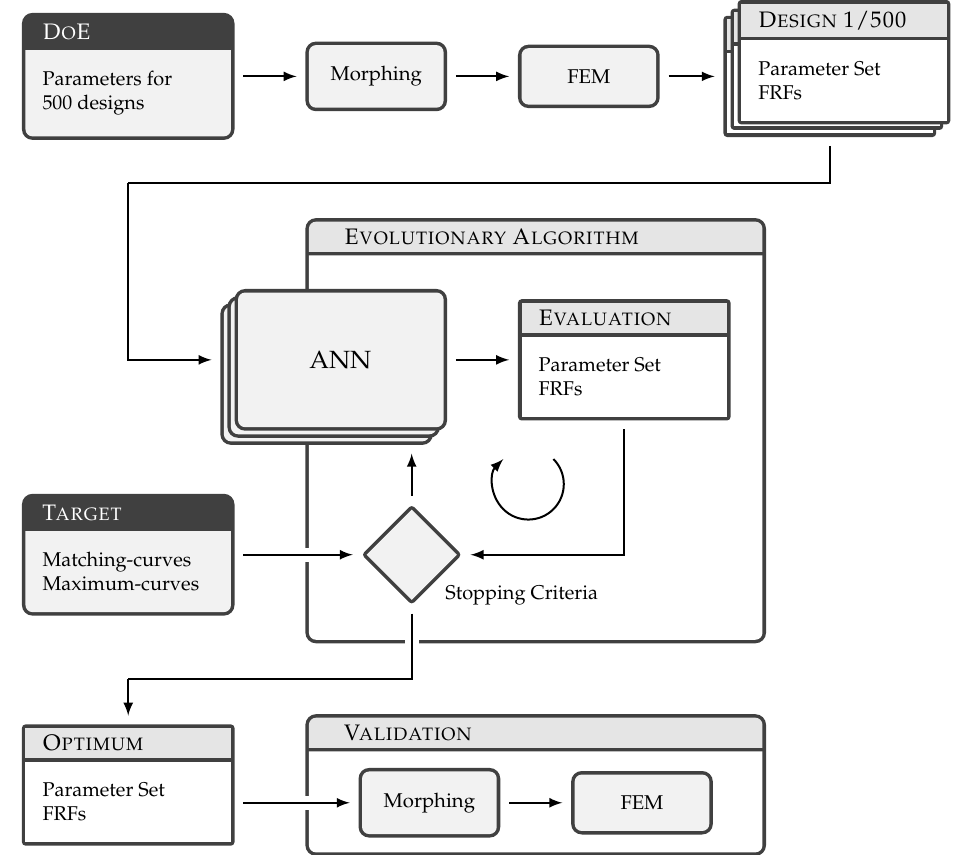
Figure 2. Flow chart representing the presented approach. The simulated designs created via DoE serve as training data for multiple ANNs. The optimizer identifies fitting parameter sets that fulfill the target curves. The identified design is then